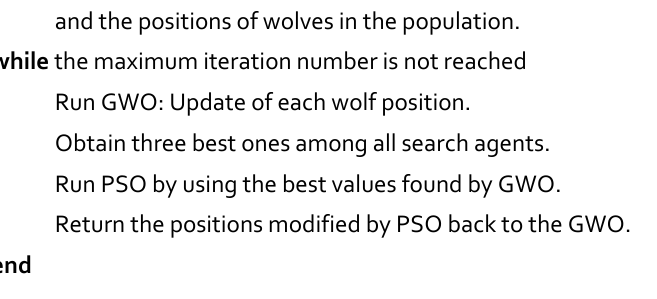
Figure 8. Pseudo code of GWO–PSO. The best positions of the grey wolves obtained at the end of the GWO–PSO algorithm represent the parameters of the controllers for each joint of the robot as follows: